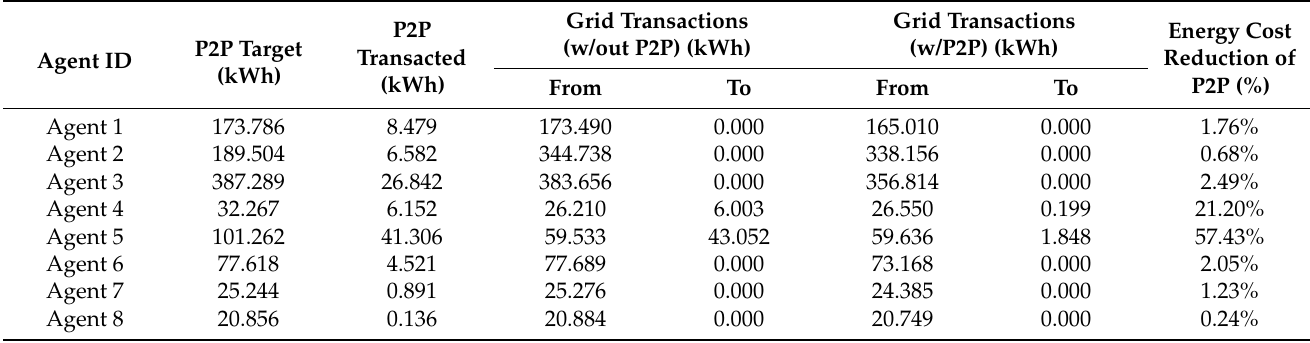
Table 3. Energy community results considering the XGBoost